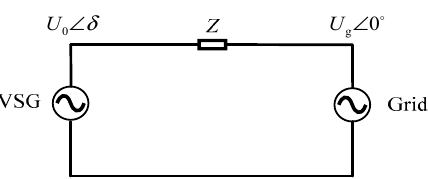
Figure 3. Equivalent diagram of grid-connected VSG.